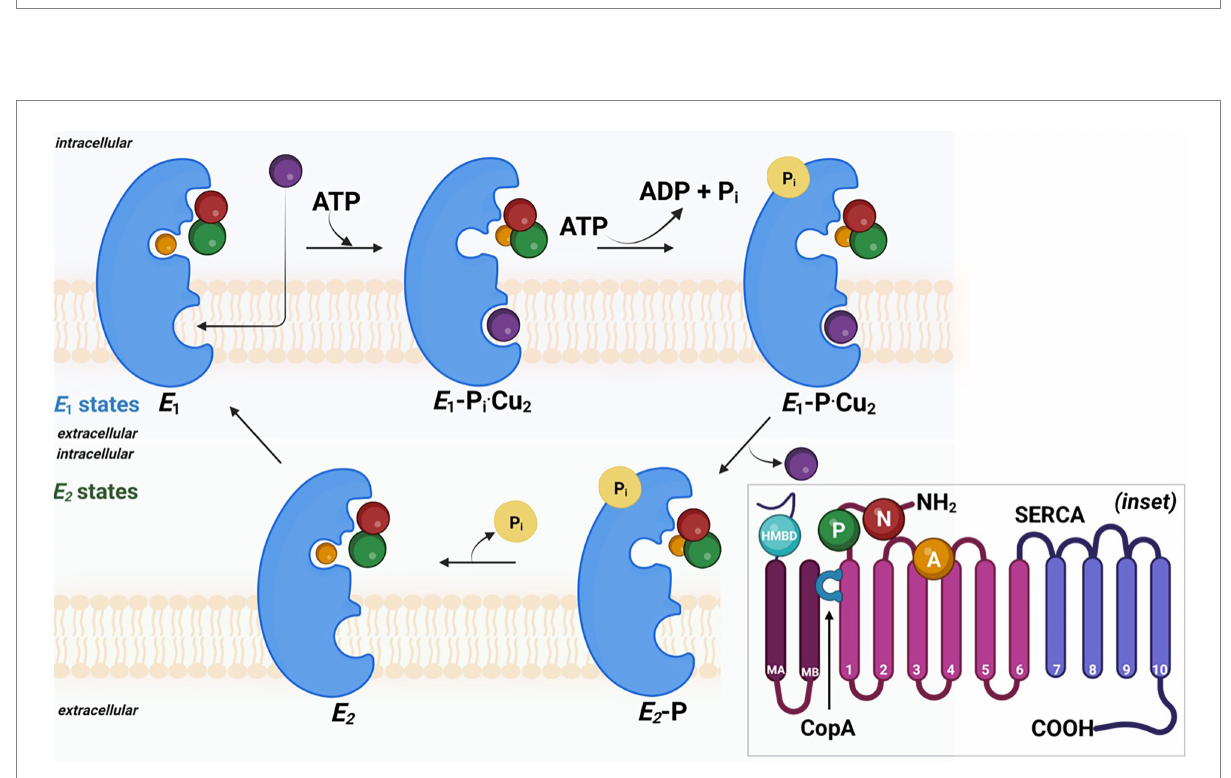
FIGURE 4 The probable mechanism involved in the copper efflux across cell membrane in sulfate reducing bacteria. Detailed 3D ribbon arrangement of different subunits and associated cofactors are shown in inset